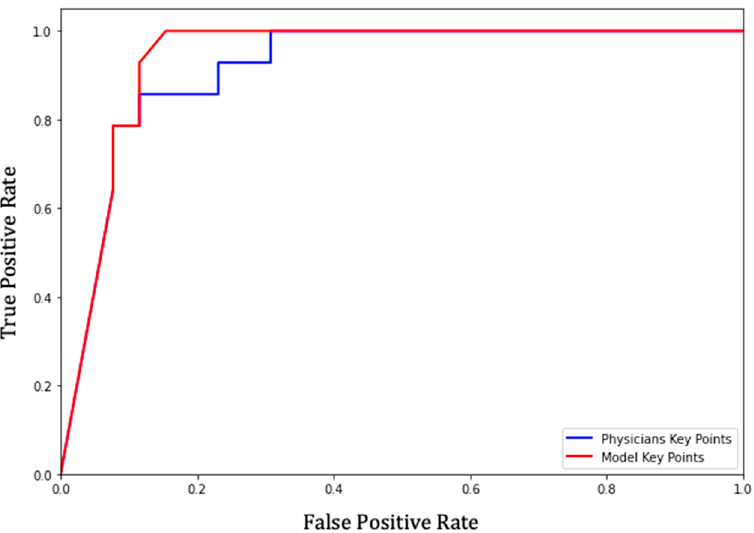
Figure 5. ROC curve for appropriateness prediction of the model. The red and blue colored lines indicate the key point curves of the model and physicians, respectively. ROC, receiver operating characteristic.